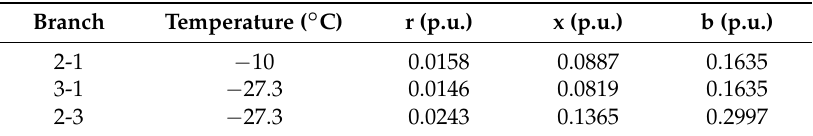
Table 7. The impedance and susceptance in case 4.